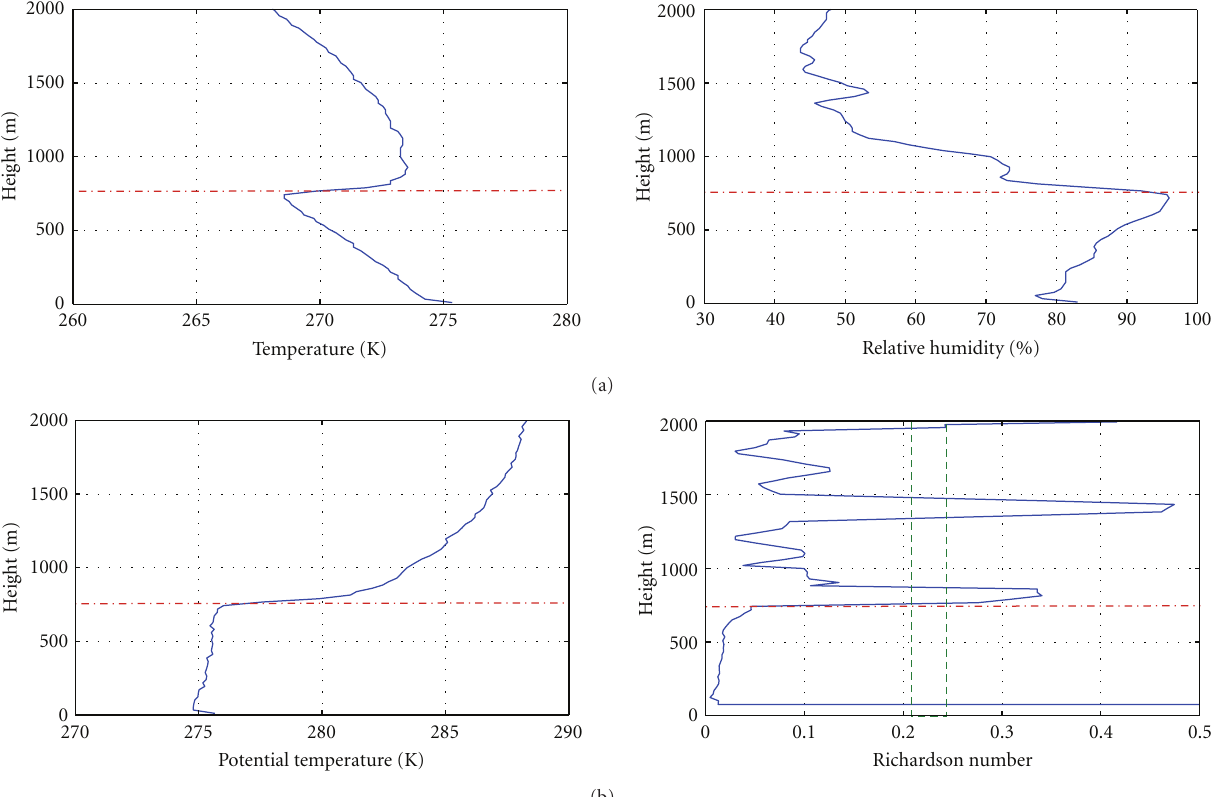
Figure 4: Determination of PBL height from thermodynamic values obtained by a VAISALA RS92 radiosonde. The radiosonde was launched at 12 UTC of the June 14th 2010 from the AWIPEV station of Ny ˚Alesund. In blue in the upper panel temperature and relative humidity while in the lower panel potential temperature and Richardson number. In dashed red the height of the PBL calculated for potential temperature with the Lapse Rate Method while the vertical green dashed lines on the fourth panel show the range of Richardson numbers between 0.21 and